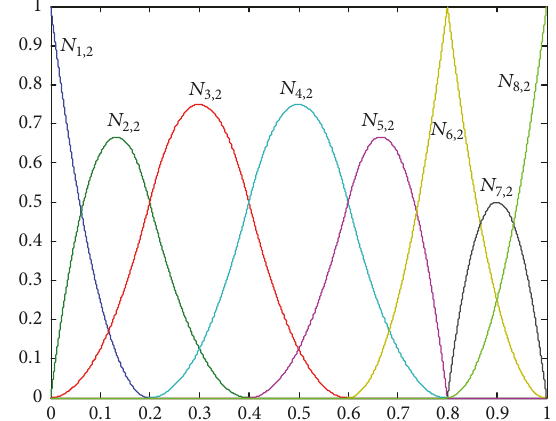
Figure 1: Quadratic basis functions for the knot vector 𝐸 = {0,0,0,1,2,3,4,4,5,5,5}